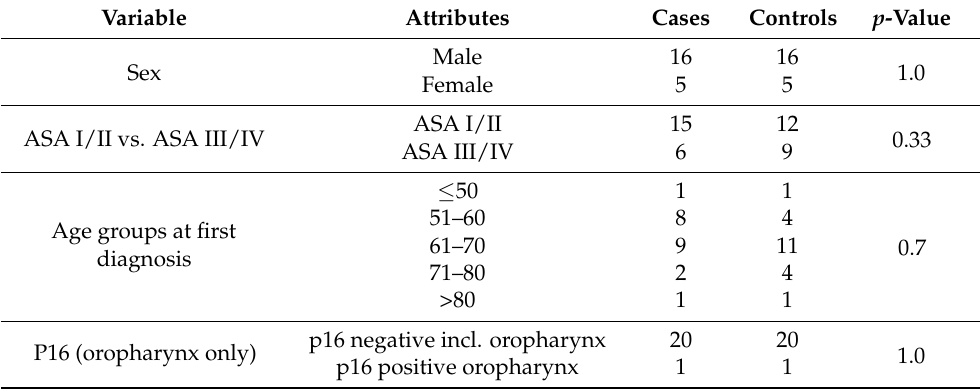
Table 3. Case control matching of surgically treated patients with treatment de-escalation (cases) and patients with primary RT ± ST (controls). Using case control matching, we identified 21 matched pairs, i.e., 21 surgically treated patients with treatment de-escalation (cases) and 21 patients with primary RT ± ST (controls). Matching variables included gender, tumor site, cT-stage, cN-stage and p16 positivity in patients with oropharyngeal carcinoma, and ASA score as a comorbidity indicator. For three surgically treated patients, no appropriate matches could be